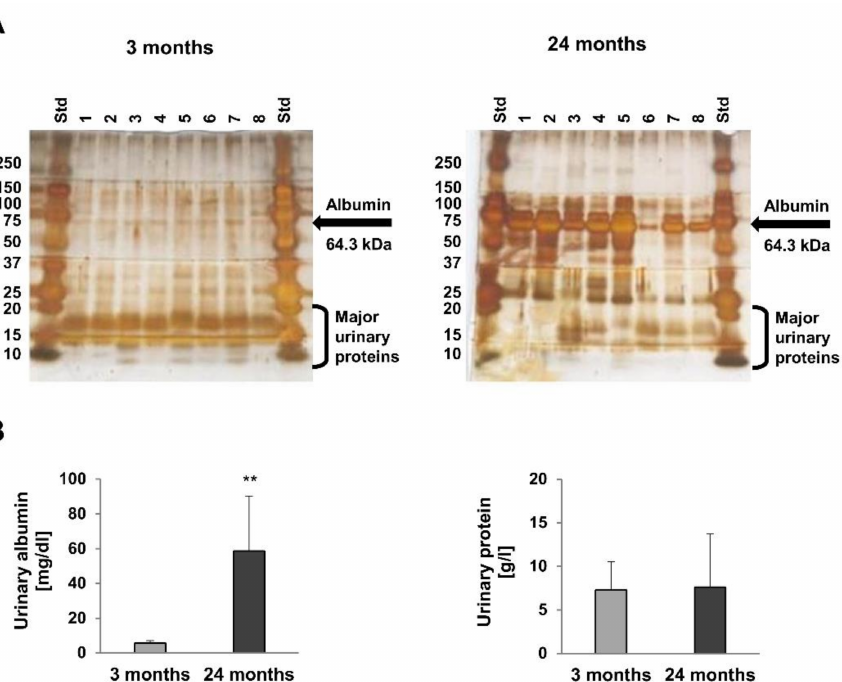
Figure 1. Urine analysis of 3- and 24-month-old rats. High levels of urinary albumin were detected in all eight 24-month-old rats by SDS-PAGE and silver staining ( A ), as well as by ELISA ( B ; p = 0.0002). The total protein level in urine was not significantly different at 3 and 24 months of age ( B ; p = 0.959). This might be explained by the presence of high levels of major urinary proteins (MUPs) in young male rats, as opposed to older rats ( A ), hence masking the detection of albuminuria in old rats in the BAC assay. ** p < 0.01 versus 3 months old